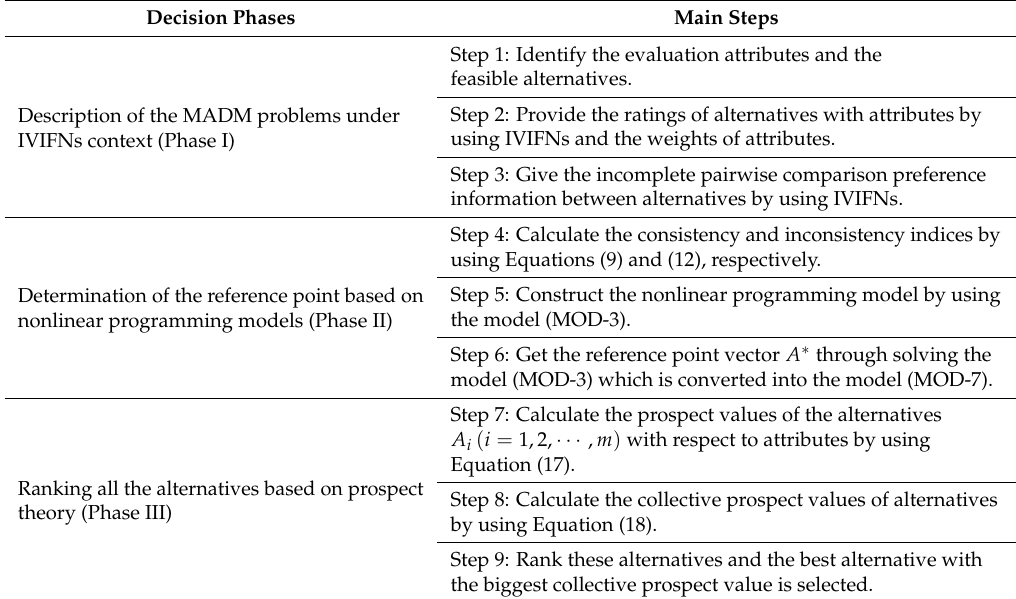
Table 1. The steps of the proposed